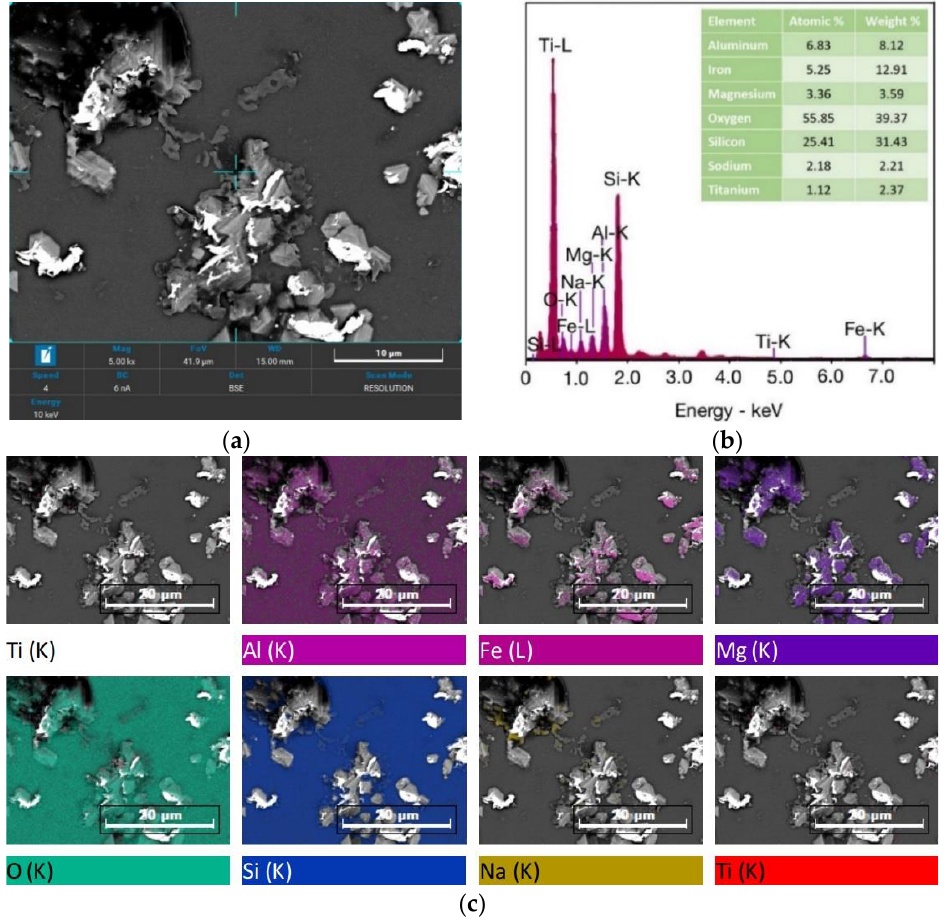
Figure 16. SEM and EDS of porcelain insulators with nano-TiO 2 coatings. ( a ) SEM image of surface; ( b ) The EDS-spectrum and quantity analysis; ( c ) The element images.